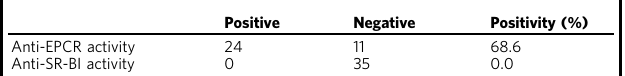
Table 2 Positivity of autoantibodies in patients with primary ulcerative